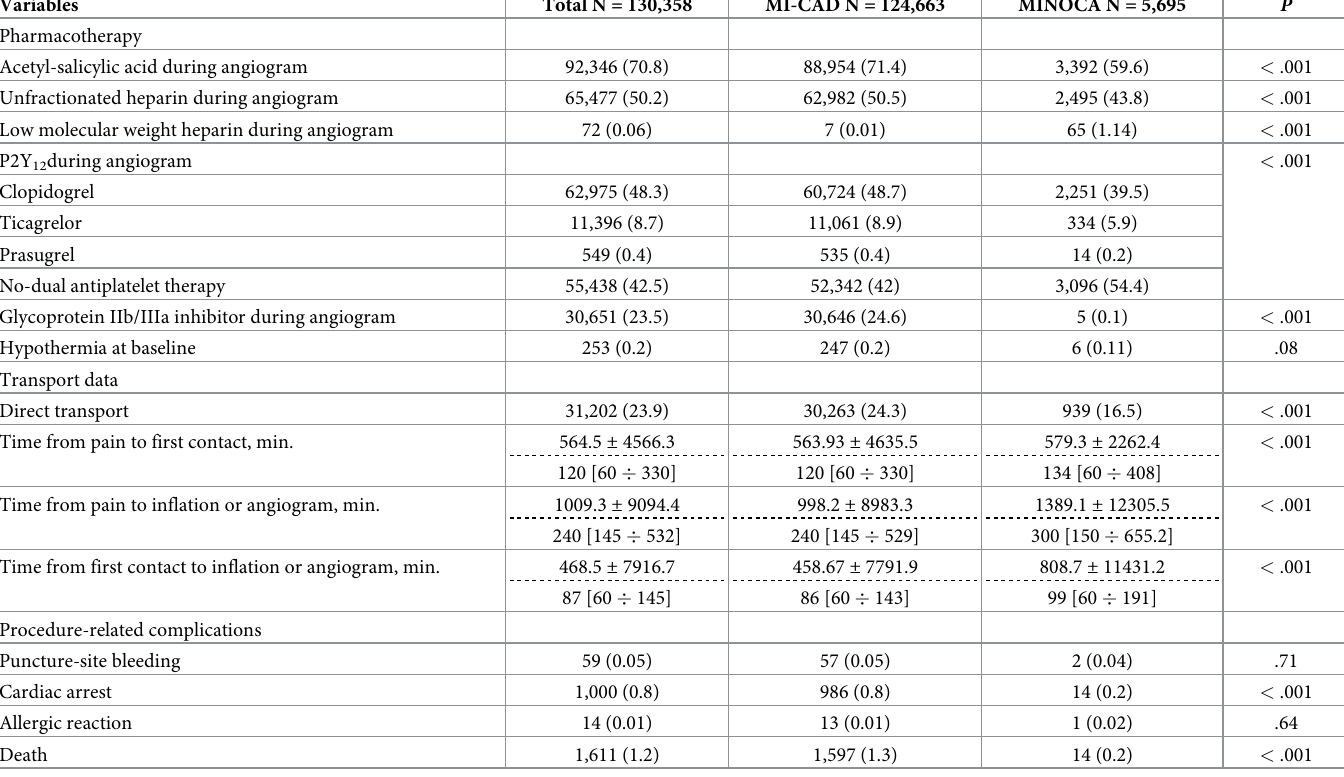
Data are presented as mean ± standard deviation, medians [lower � upper quartile] for asymmetric distribution or counts (percentages); percentages reflect available study